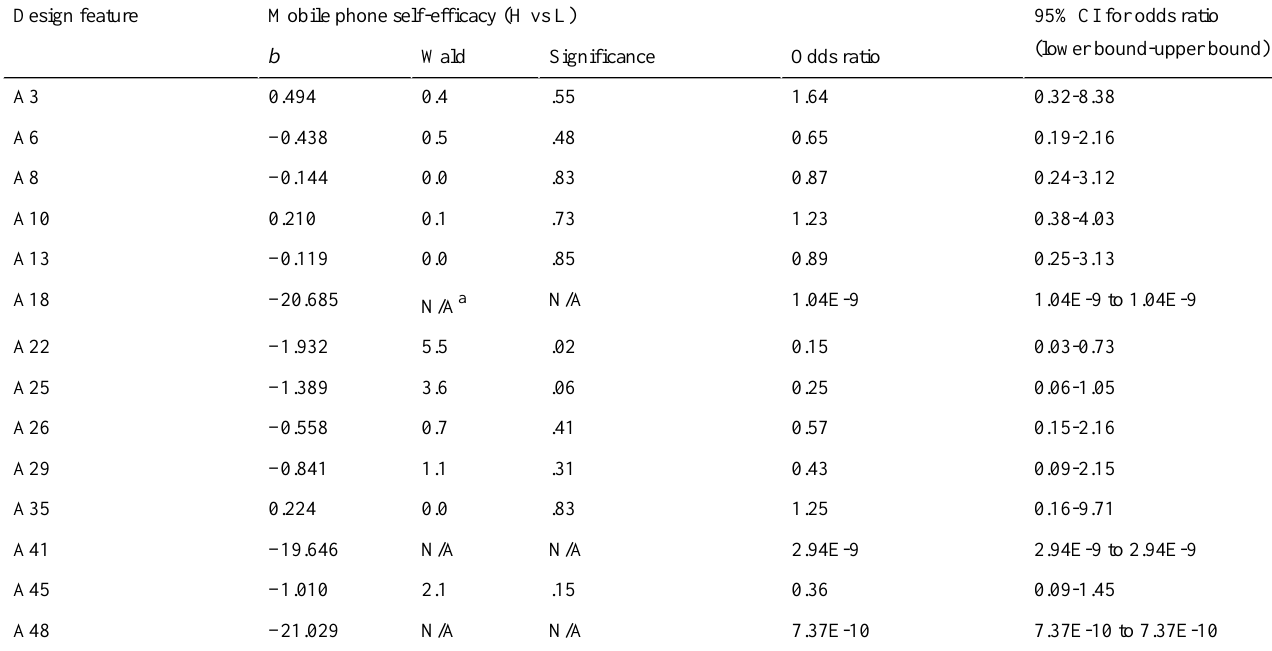
Table 13. Parameter estimates of change of mobile phone self-efficacy (MPSE) from medium to high ( must-be over indifferent